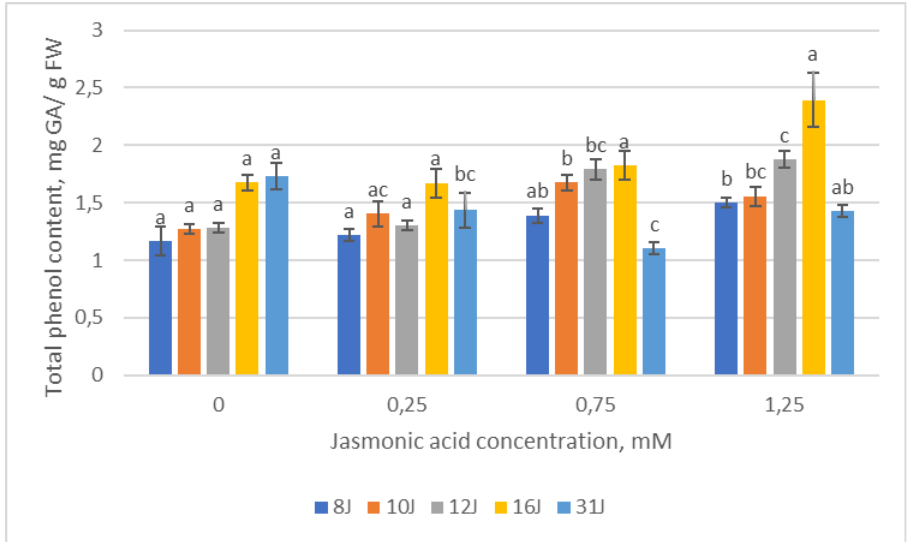
Figure 6. Means (mg/g) ± SE of total phenolic compounds of five half-sib families of Scots pine, assessed 6 weeks after sowing. Data significance was calculated using the Kruskal–Wallis H test for ranks and post hoc Dunn’s test for pairs ( p < 0.05). Different letters next to different colors indicate significant differences between the groups, sprayed with different concentrations of jasmonic